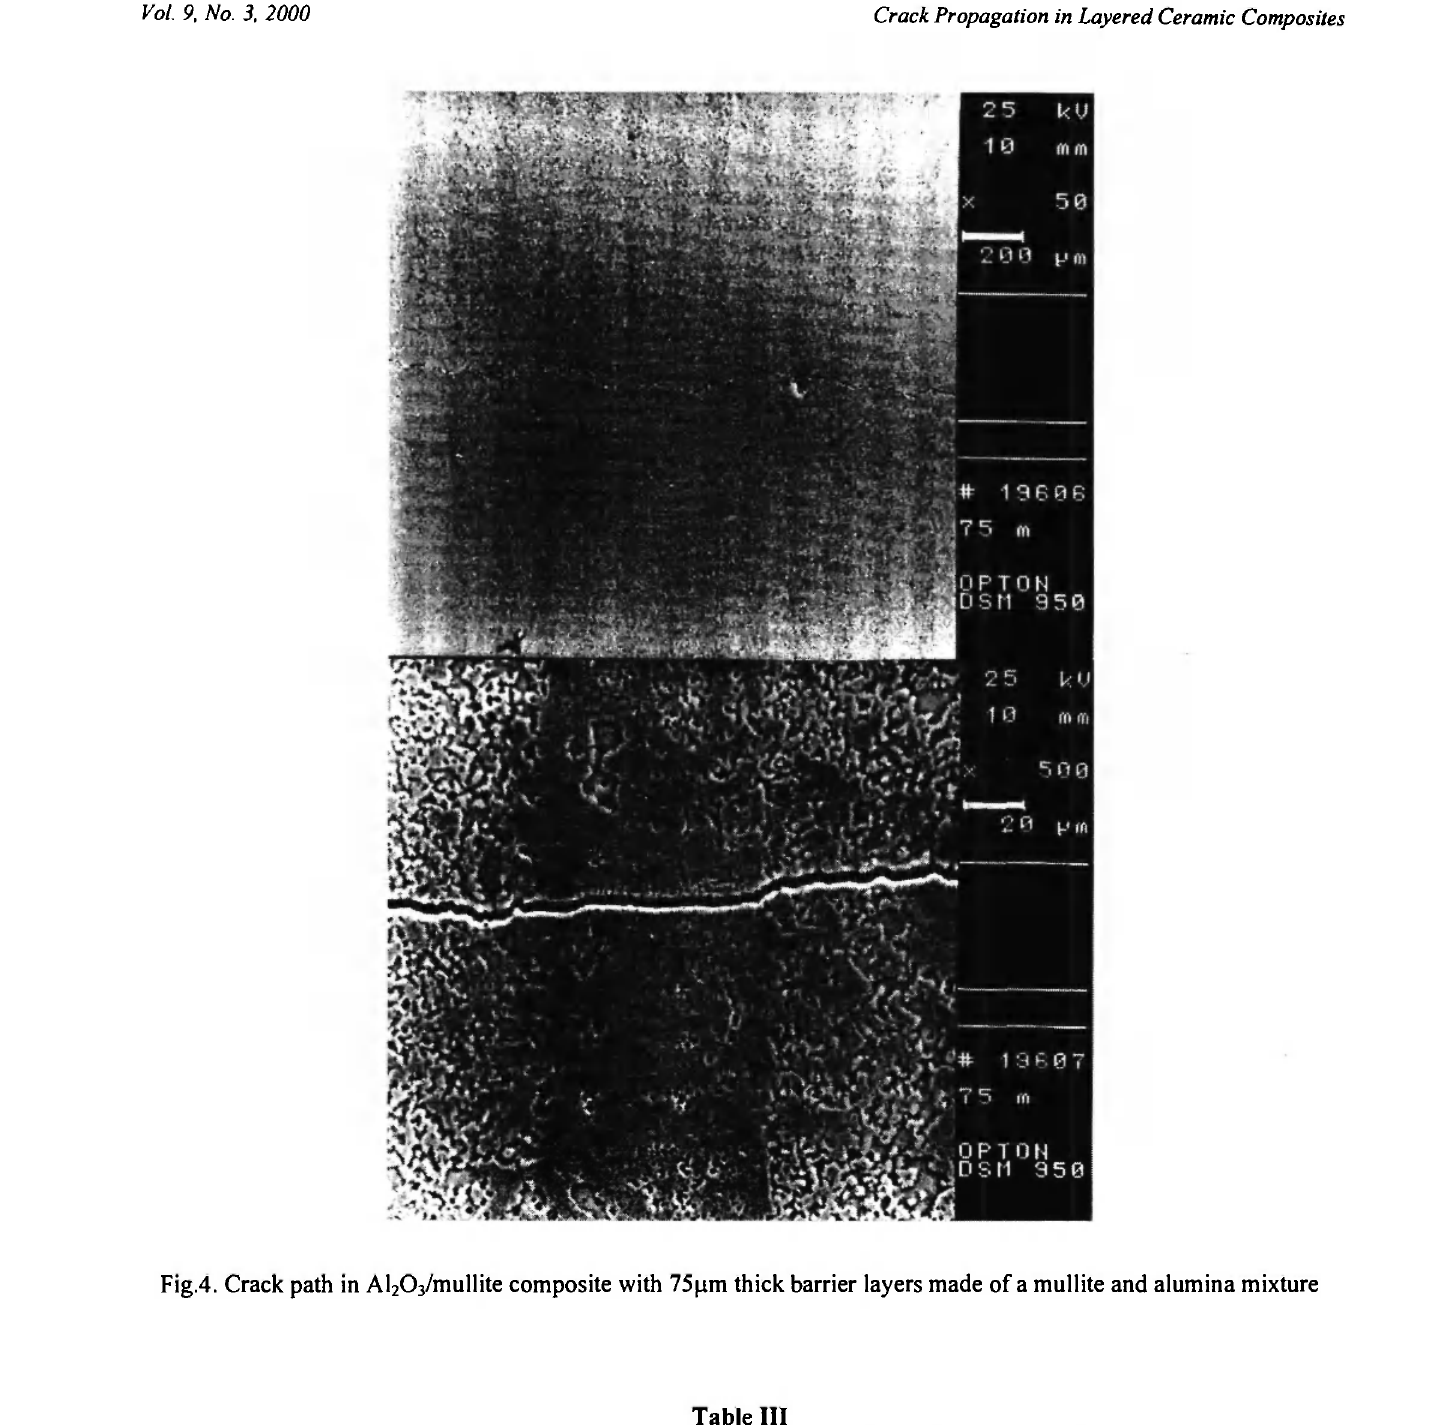
Linear coefficients a and b (equation K,=ac+b) for layered composites of alumina and mullite and of alumina and alumina/mullite mixture